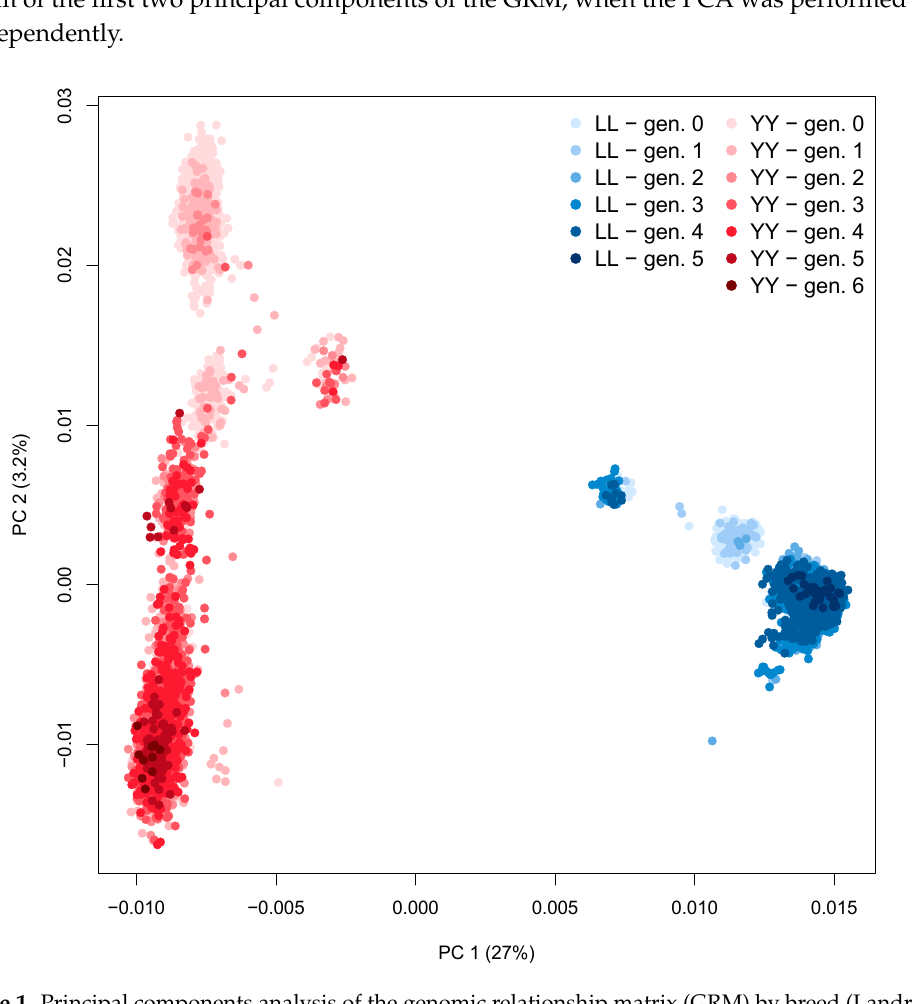
Figure 1. Principal components analysis of the genomic relationship matrix (GRM) by breed (Landrace (LL) and Yorkshire (YY)) and generations (zero to six).